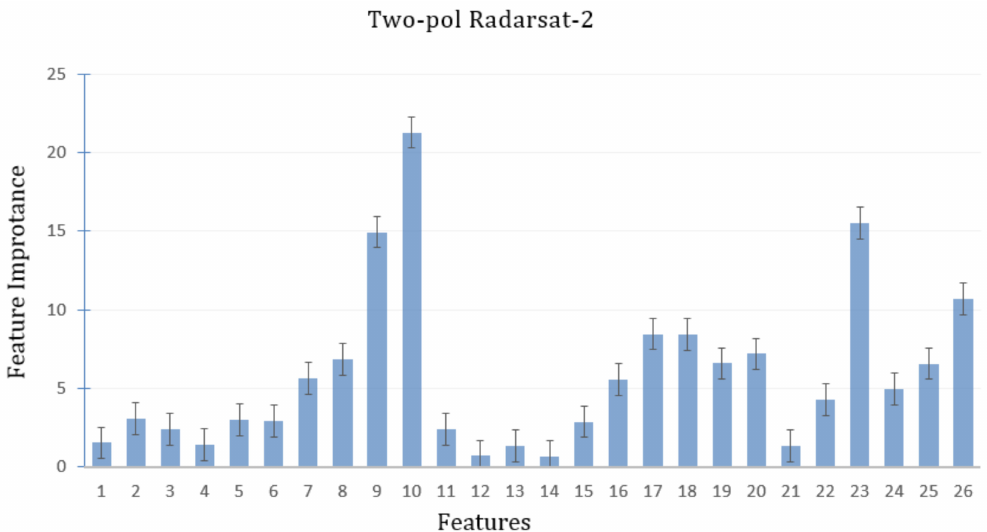
Figure 7. Bar graph of the average and standard deviation values of the importance of each variable to mapping of plastic-mulched farmland and other land cover types in Jizhou using dual-polarimetric RADARSAT-2 data, as assessed by the random forest algorithm. Values 1–26 reflect their listing in Table 2.